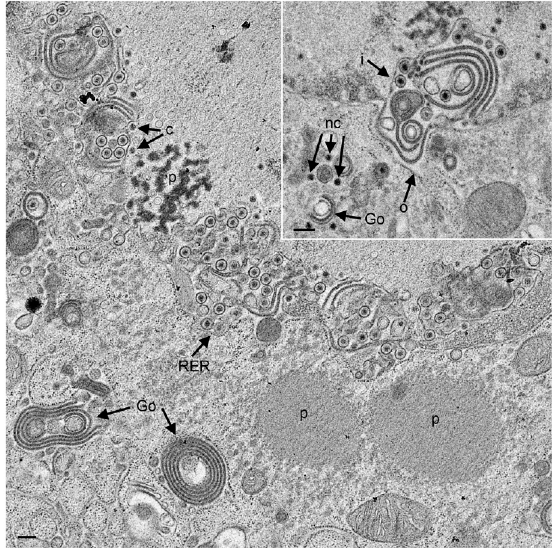
Figure 1. Transmission electron microscopy of Vero cells 24 hpi with CK177 Δ Us3gK-HA. The inner nuclear membrane (INM) (i) formed invaginations and multiple folds shown in detail in the inset. Capsids (c) bud at the INM, and virions accumulate in the perinuclear space delineated by the INM and outer nuclear membrane (ONM) (o), and to a much less extent in adjacent cisternae of the endoplasmic reticulum (RER). A few naked capsids (nc) are in close vicinity to Golgi membranes (Go). Note the presence of electron dense material (p) with the appearance of proteins in the nucleus and the cytoplasm. Bars, 200